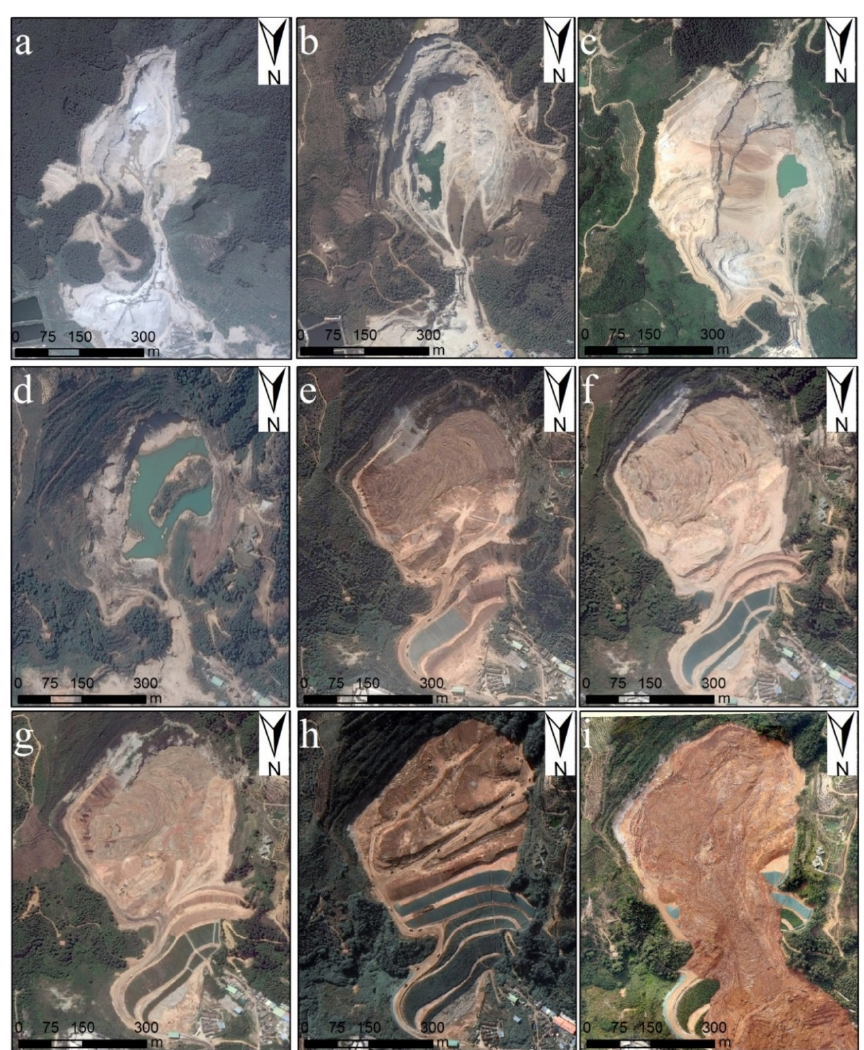
Figure 7. Multi-temporal remote-sensing images of the study area. (a) 31 August 2002; (b) 20 February 2008; (c) 30 August 2010; (d) 25 November 2013; (e) 17 November 2014; (f) 23 January2015; (g) 14 April 2015; (h) Pléiades (18 December 2015); (f) aerial (23 December 2015). Panels (a) to (g) were obtained from Google Earth. A service road was excavated at the exit of the quarry with a width of nearly 70m (see panels a , b , c , and d